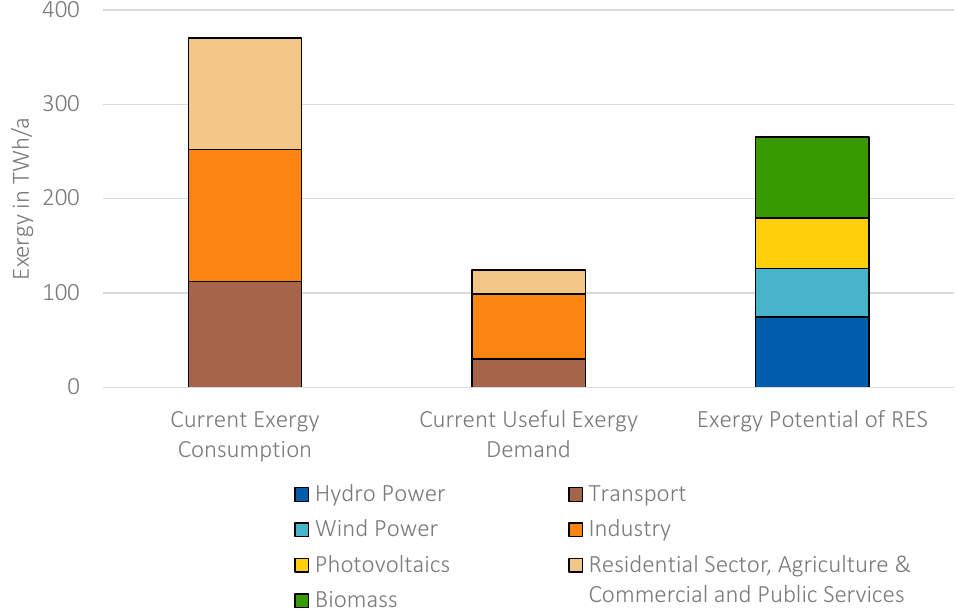
Figure 10. Austria-wide comparison of the current exergy consumption (approx. 370 TWh/a), the useful exergy demand (approx. 125 TWh/a) and the technical exergy potential of RES (approx. 266 TWh/a). In Austria, the current exergy consumption cannot be covered by the technical exergy potential of RES. Therefore, the exergy consumption must be significantly reduced to enable exergetic self-sufficiency. The comparison of the current exergy consumption with the current useful exergy demand shows that significant savings are possible.